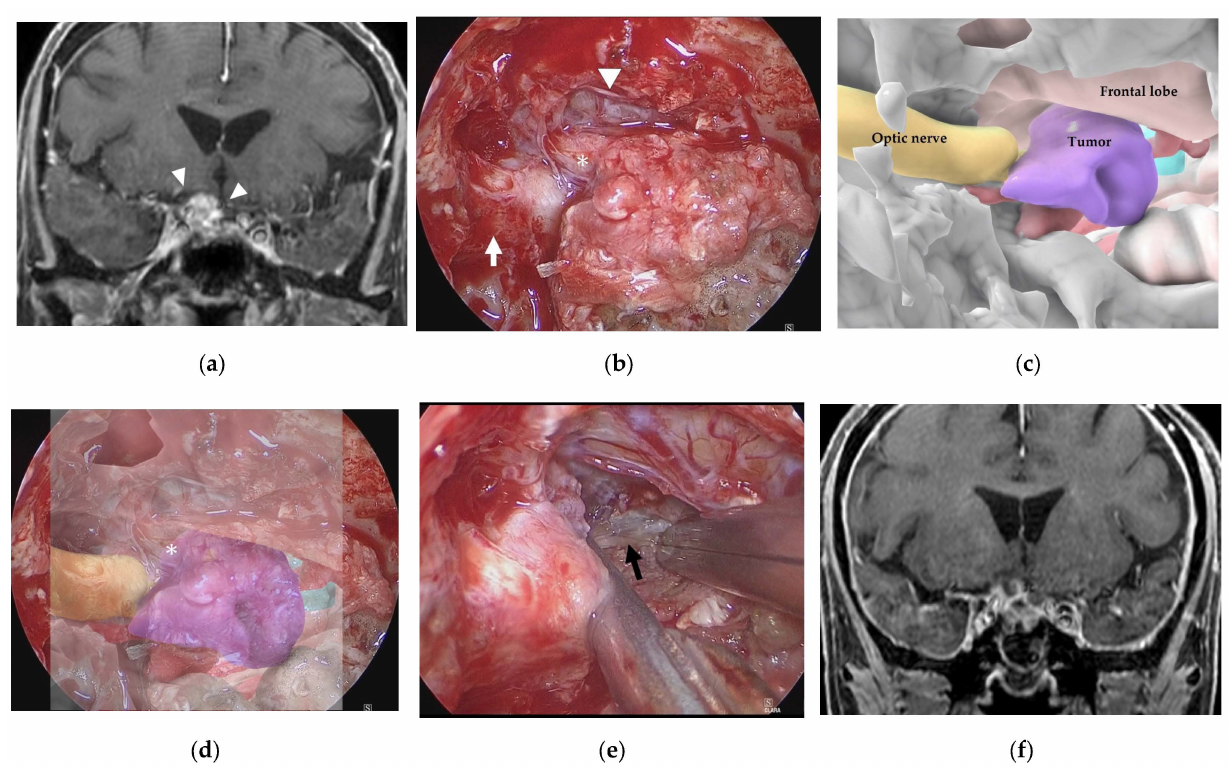
Figure 6. Illustrative case 3. ( a ) Coronal section of preoperative gadolinium enhanced T1 weighted image shows a tumor around the right optic nerve (white arrowheads). ( b ) Neuroendoscopic image in the sphenoid sinus after cutting the thick mucosa shows the right optic sheath (white arrow), right frontal lobe (white arrowhead), and a tumor-like structure (white asterisk). ( c ) 3DCG shows the location of the tumor medial to the right optic nerve and inferior to the frontal lobe. ( d ) Fusion image shows that the tumor-like structure is coincident with the tumor observed in the 3DCG (white asterisk). ( e ) The right optic nerve (black arrow) is exposed after removal of the tumor. ( f ) Coronal section of postoperative gadolinium-enhanced T1 weighted image shows subtotal removal of the